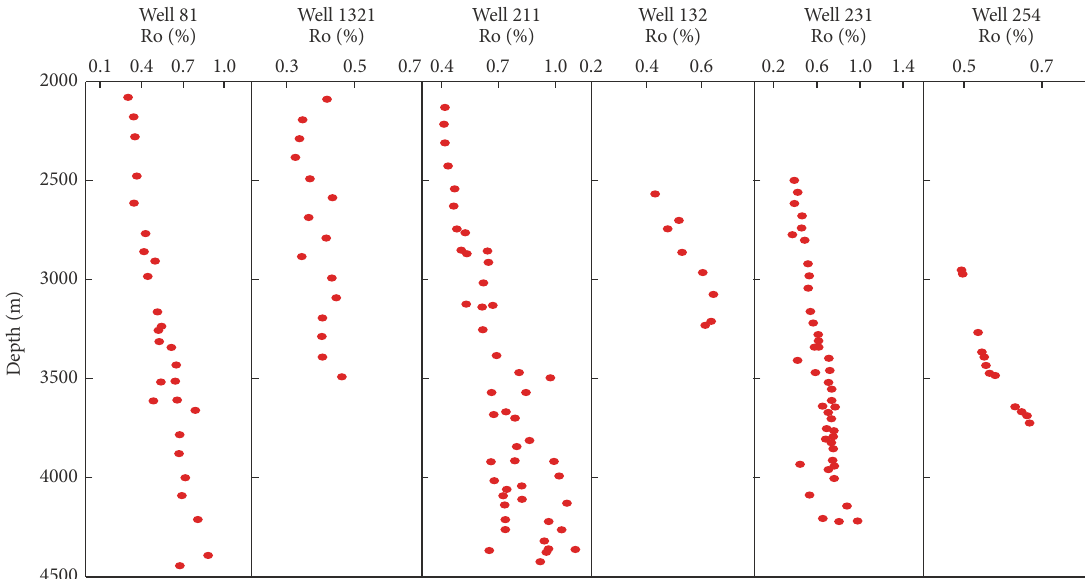
Figure 7: Measured vitrinite reflectance (Ro) of the Eocene source rocks in the Huizhou